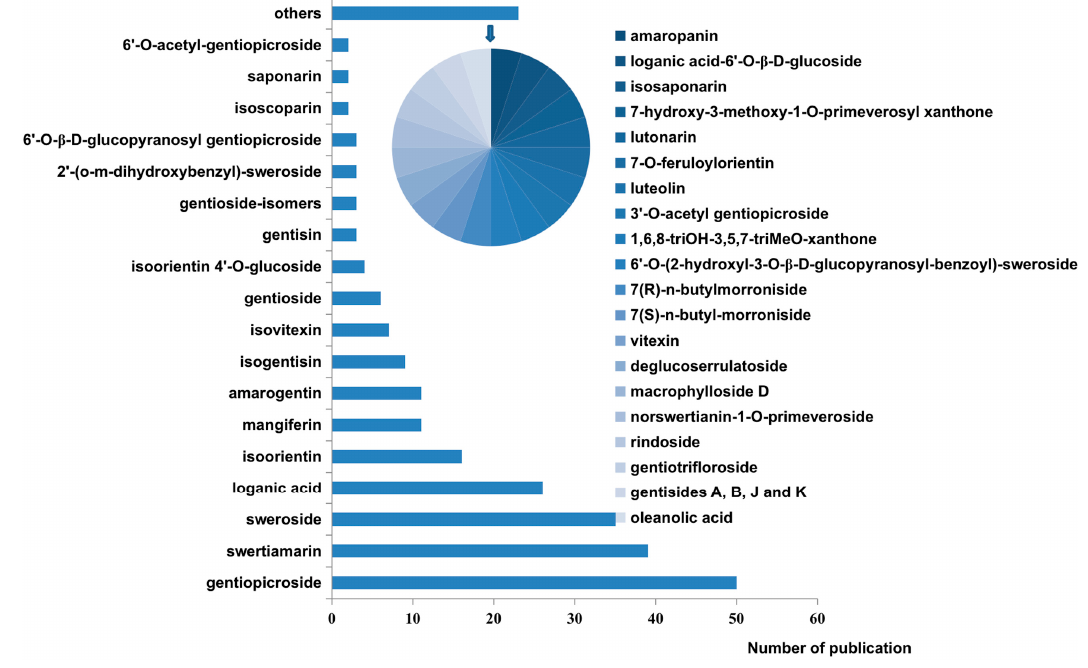
Figure 1. All compounds detected by analytical methods.